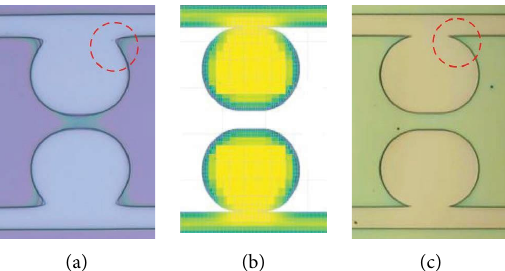
Figure 5: Circular PCA: (a) problematic uniform dosage, (b) PEC corrected CAD model, and (c) modulated dosage. Tese images were taken using an optical microscope. Te diference in colors between 5(a) and 5(c) is due to the PMMA resist in 5(a) and the Cr/Au metallization in